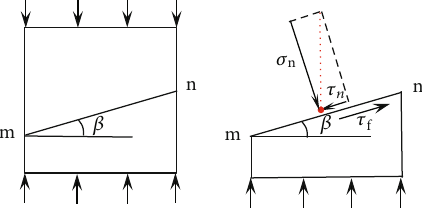
Figure 8: Stress components during axial